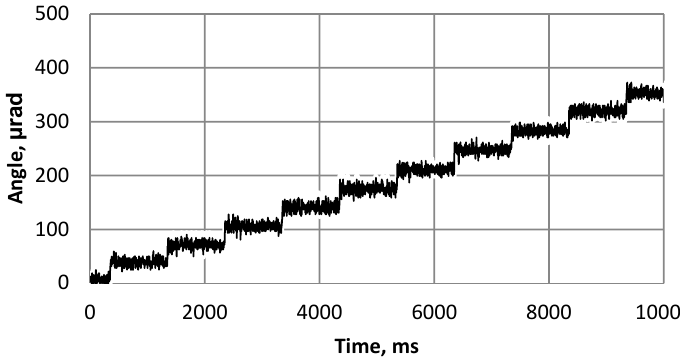
Figure 15. Measured resolution results of angular motion of the sphere.